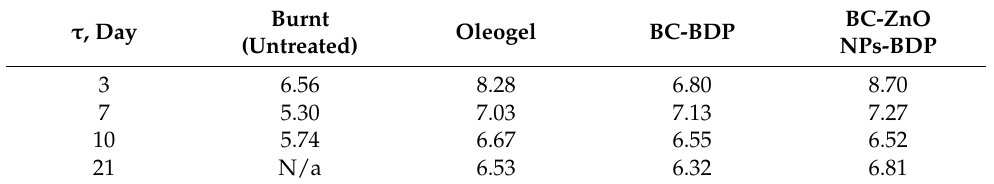
Table 5. Data of the LDH reverse ratio, calculated using data of Table 4 1 . LDH direct